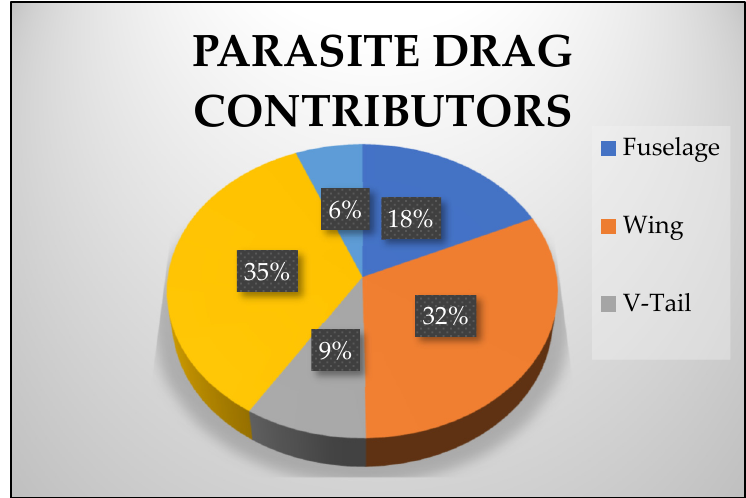
Figure 22. Pie chart of major contributors of parasite drag. Table 14. Boundary conditions for drag calculations.